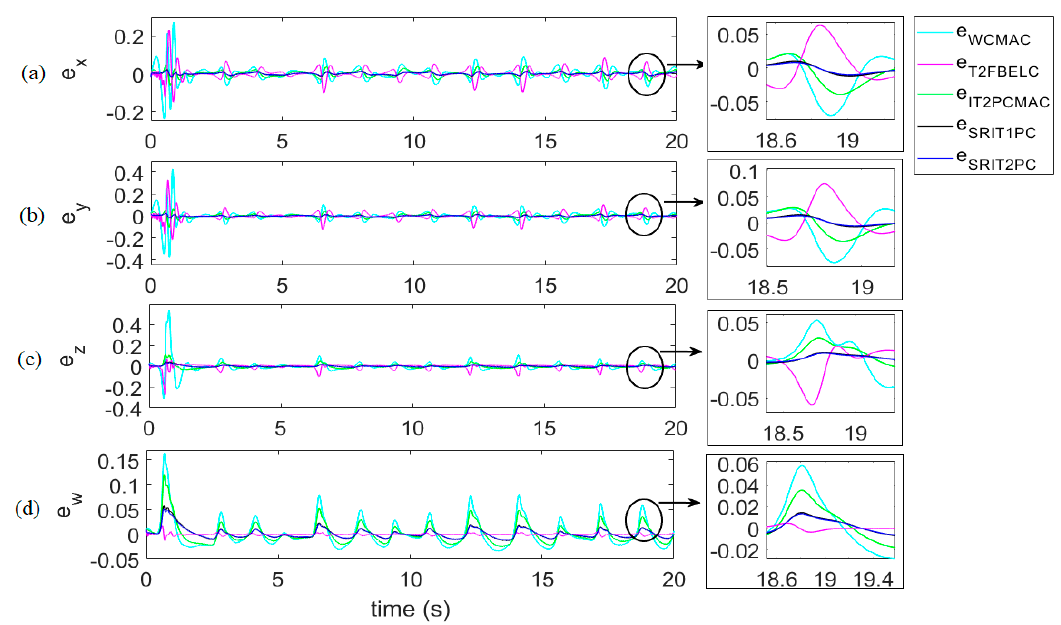
Figure 15. Tracking errors between the proposed SRIT2PC and other synchronization methods for Case 2: ( a ) e x , ( b ) e y , ( c ) e z , and ( d ) e w .